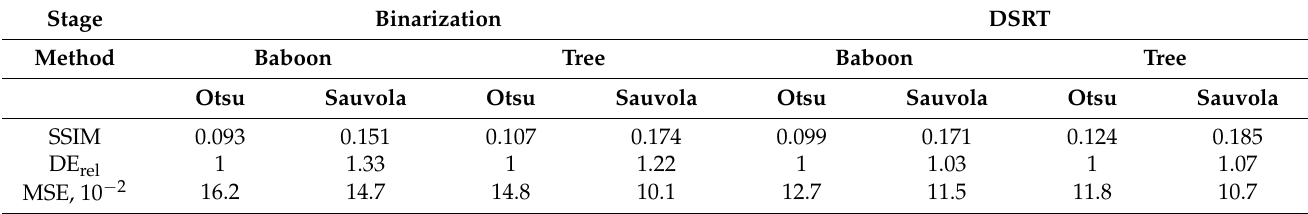
Table 3. Quality and diffraction efficiency of the optically reconstructed binary